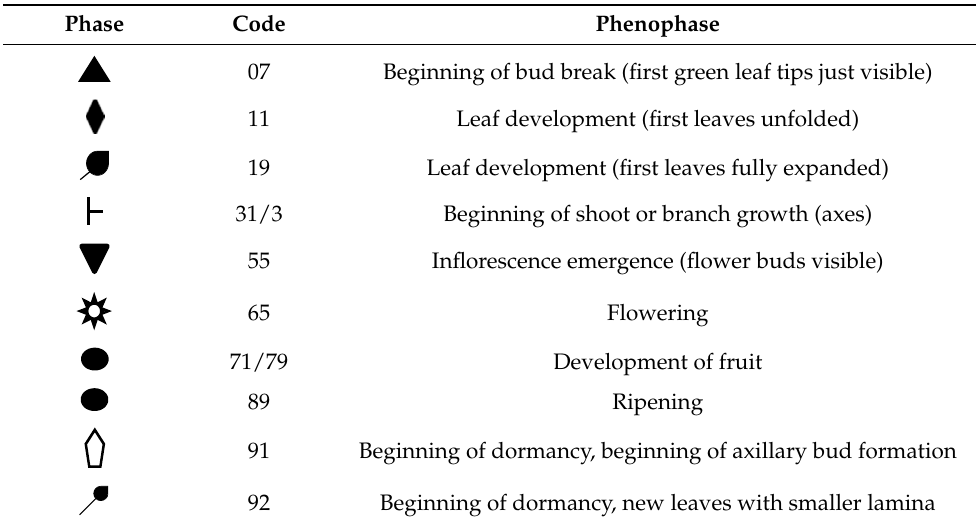
Figure 2. Phenology and cambial activity of Acaena elongata over the altitudinal gradient, Sierra